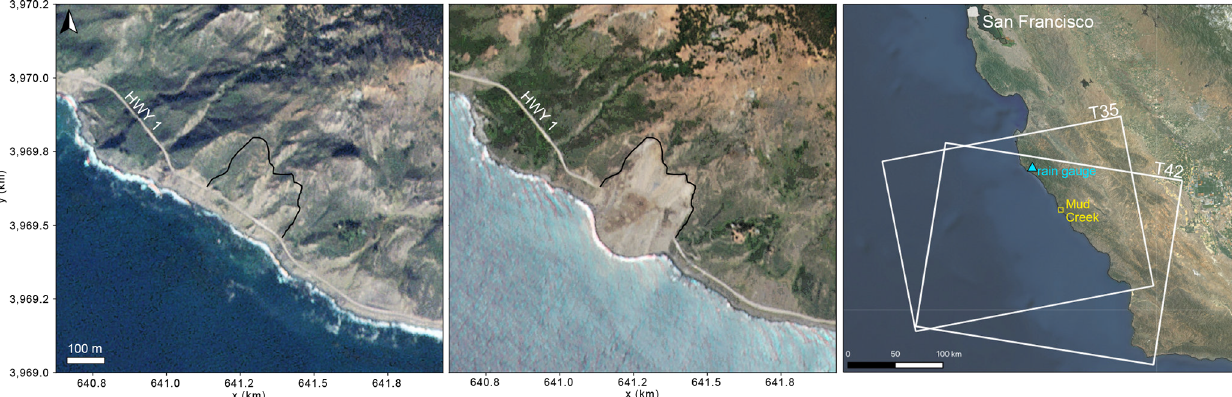
Figure 1. Big Sur coast with Highway 1 before and after the Mud Creek landslide (left and center, x and y coordinates in UTM zone 10N; images from © Planet Team, 2017), and landslide and rain gauge locations and Sentinel-1 ascending (T35) and descending (T42) orbit footprints (right; basemap from ESRI World Imagery; source: Esri, Maxar, GeoEye, Earthstar Geographics, CNES/Airbus DS, USDA, USGS, AeroGRID, IGN, and the GIS User Community). Table 1. Overview of data products used in this study and the number of products derived at the different processing